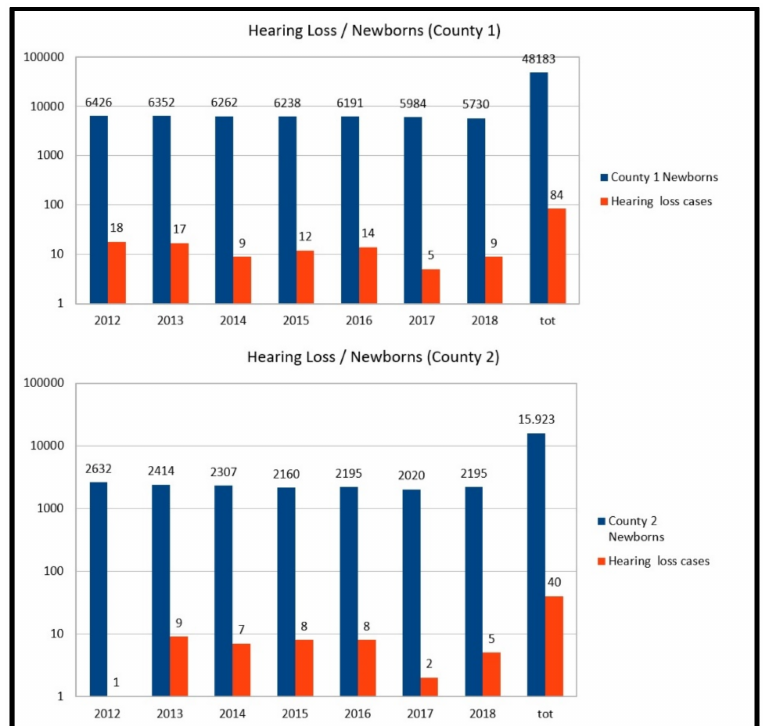
Figure 1. For each county, the total number of newborns per year is indicated (first column), related to the number of new cases of hearing loss treated by territorial services (second column). The prevalence of hearing loss is calculated for the whole period of the study by total number of newborns/number of hearing loss cases, indicated in the last two columns on the right side of the